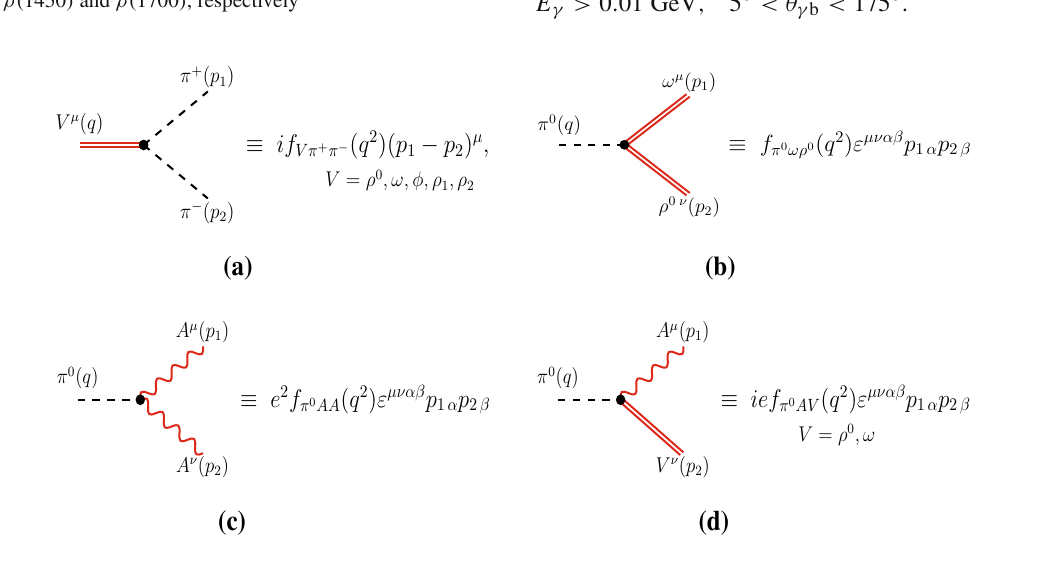
Fig. 8 Triple vertices of the HLS relevant for the present